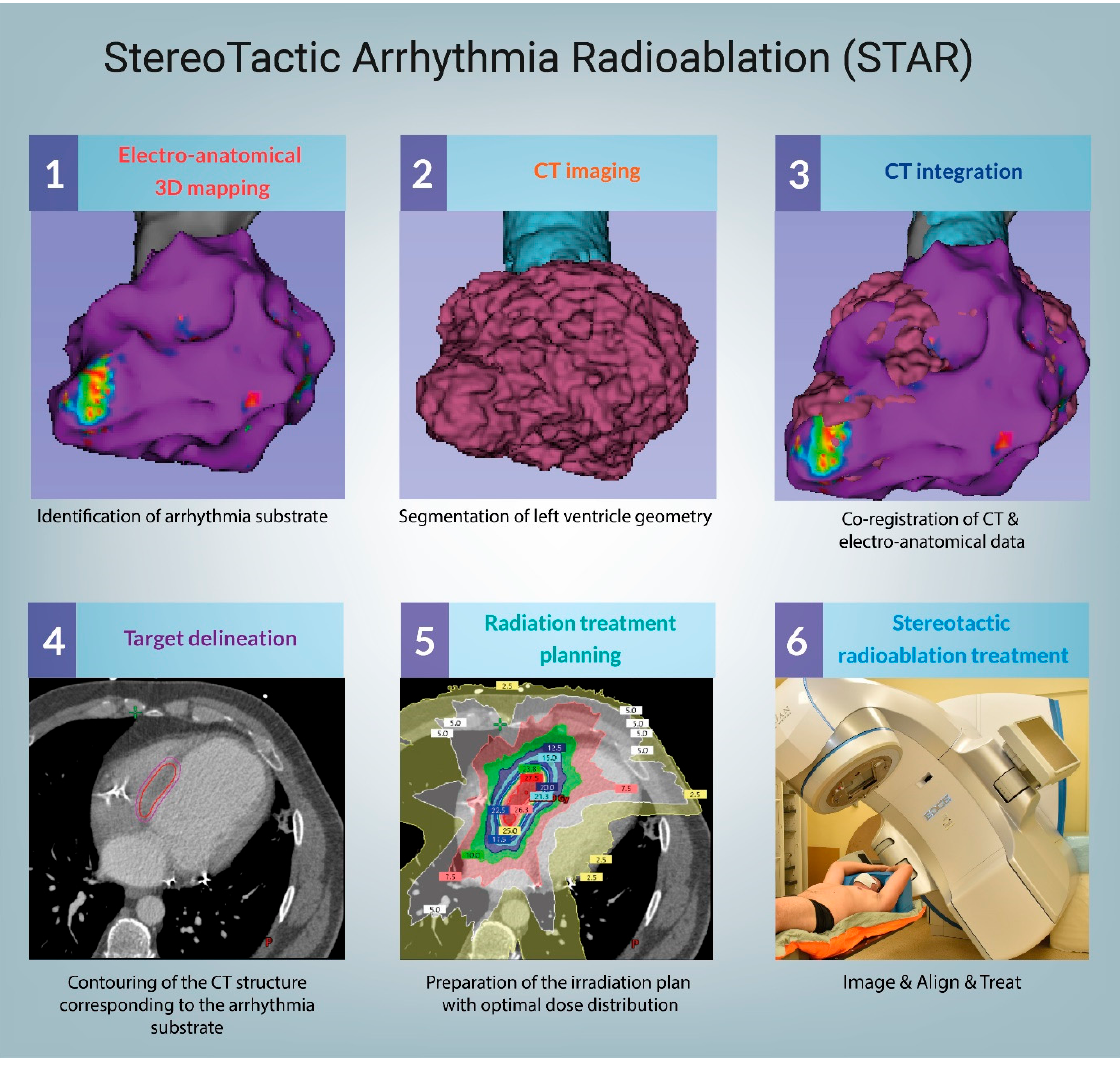
Figure 1. Procedural workflow. CT–computed tomography.